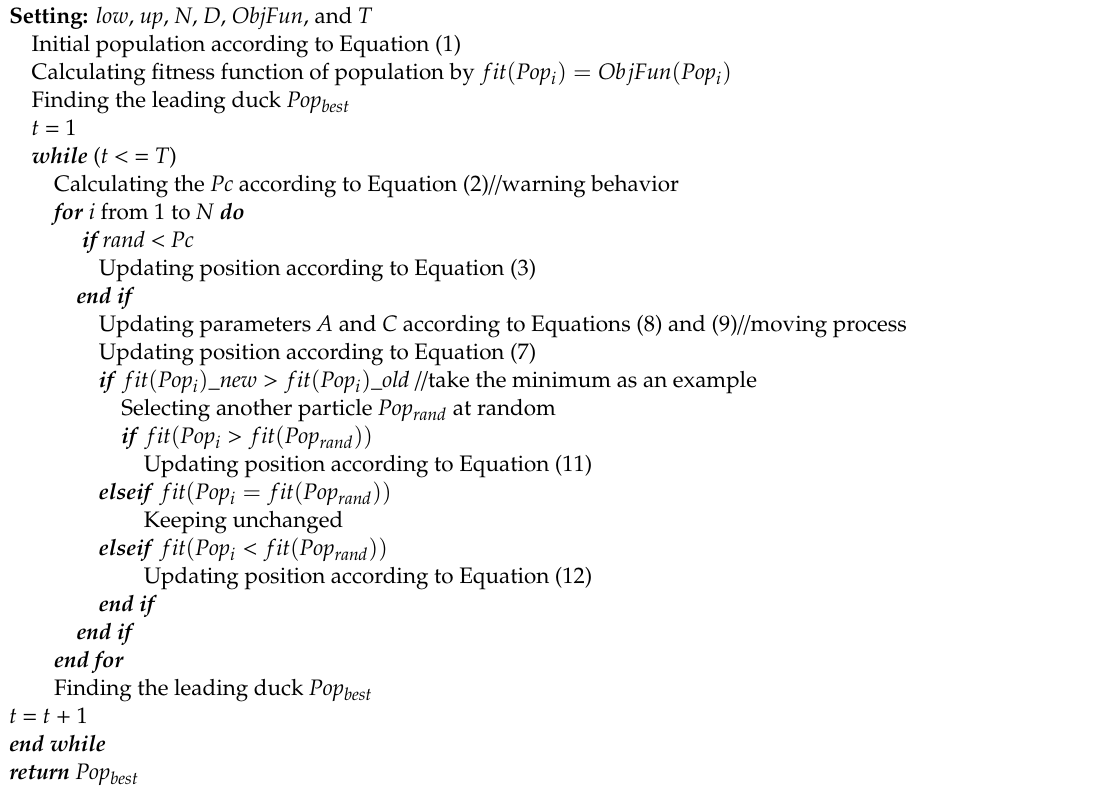
Table 1. Pseudo code of the anas platyrhynchos optimizer (APO).